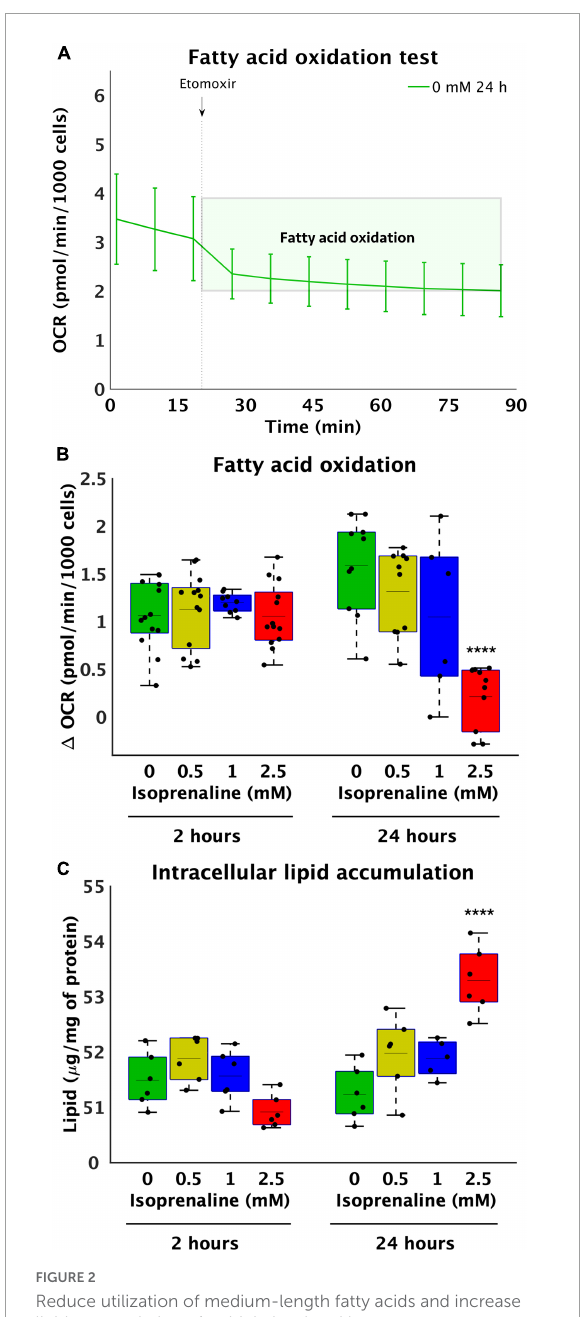
FIGURE2 Reduce utilization of medium-length fatty acids and increase lipid accumulation after high-level and long-term exposure to isoprenaline. (A) Representative graph of the oxygen consumption rate (OCR) of HL-1 cardiomyocytes before and after 40 µ M etomoxir inhibition. (B) Quantification of fatty acid oxidation calculated from (A) . Statistical significance was assessed using two-way ANOVA (effect of concentrations: p = 4.53 × 10 − 7 , time: p = 0.5643, interaction: p = 1.76 × 10 − 6 ) followed by Sidakholm multiple comparisons. (A,B) n = 12 biological replicates per group, one technical replicate, (C) Intracellular lipid accumulation in HL-1 cardiomyocytes expose to 0 mM, 0.5 mM, 1.0 mM, and 2.5 mM levels of isoprenaline for 2 h and 24 h (effect of concentrations: p = 7.03 × 10 − 5 , time: p = 0.0043, interaction: p = 2.13 × 10 − 7 ). n = 6 replicates per group, 2 technical